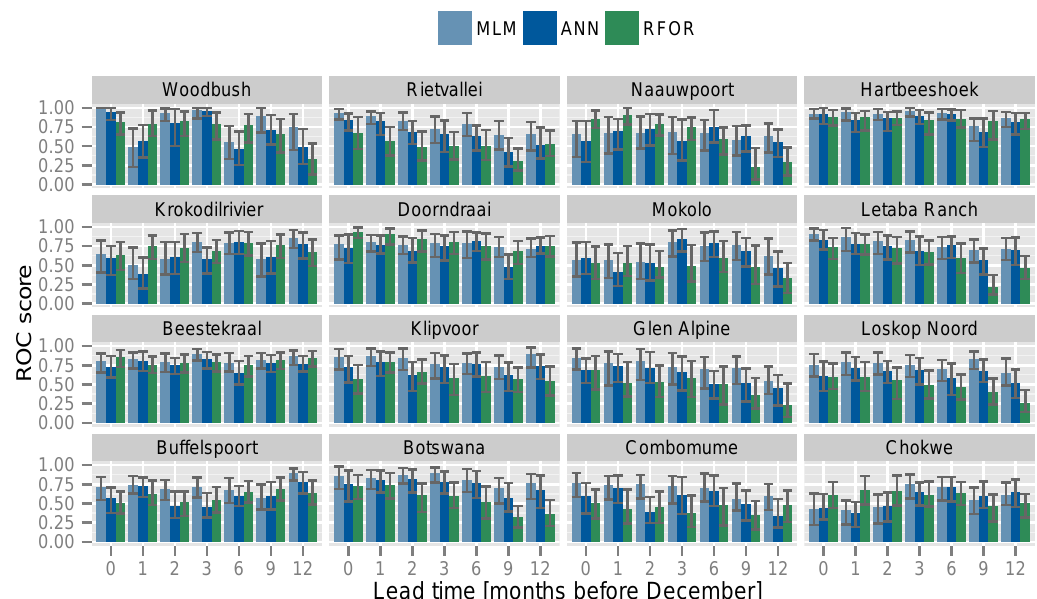
Figure 12. Validation of DJFMAM drought forecasts with ROC scores: ANNs (dark blue), MLMs (bright blue) and RFORs (green). Bars indicate median ROC scores, error bars show bootstrapped 0.95 confidence intervals of the scores. Stations are ordered increasingly by catchment area from small (top left) to large (bottom right).